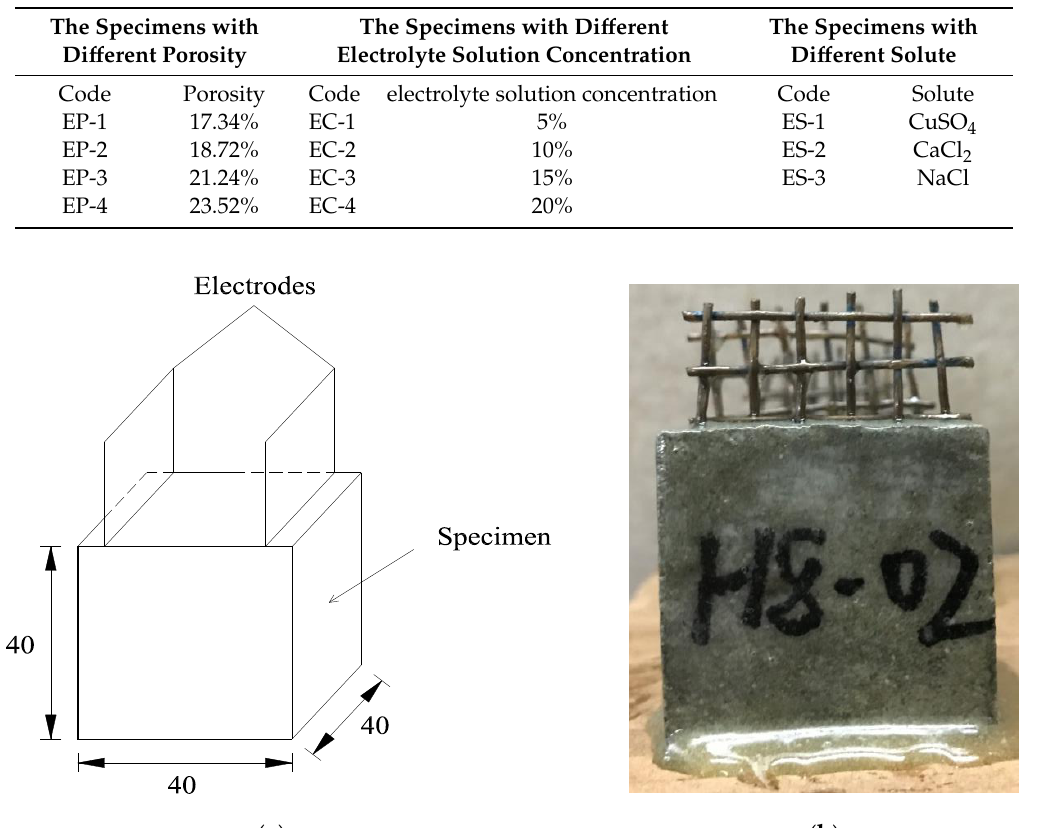
Table 5. The specimen codes for electrochemical impedance spectroscopy (EIS) test.